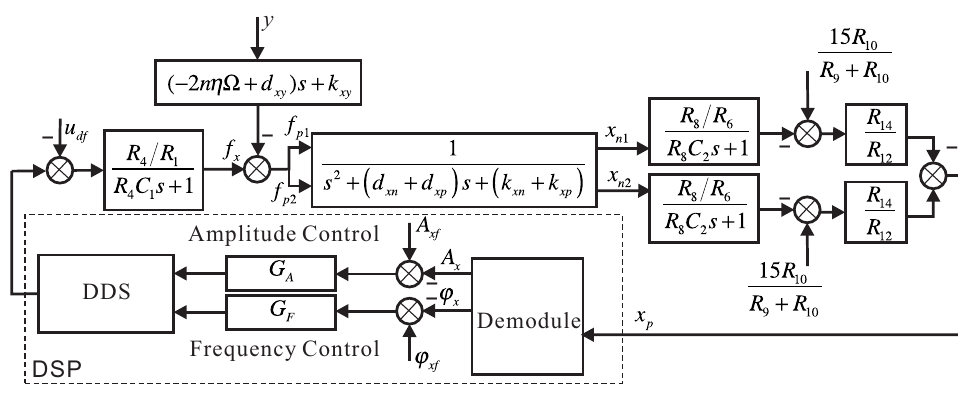
Figure 13. The structure frame of the x -axis control